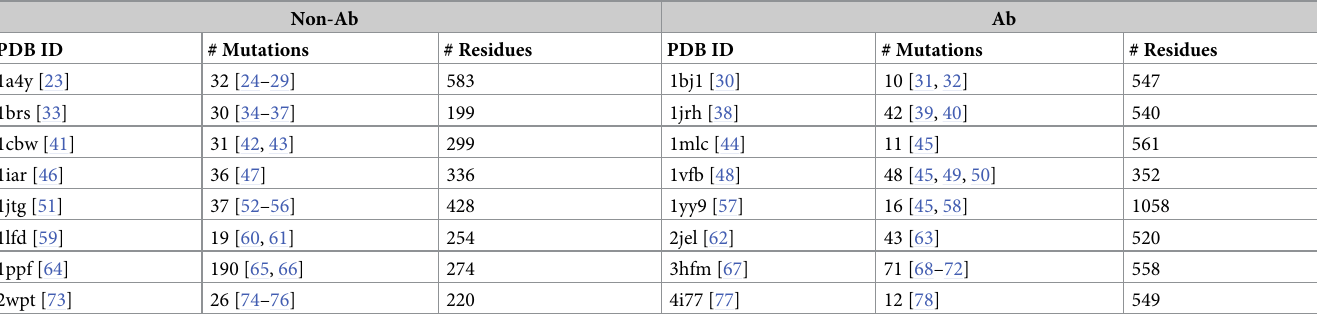
Table 1. Dataset used in our study containing 16 protein complexes.